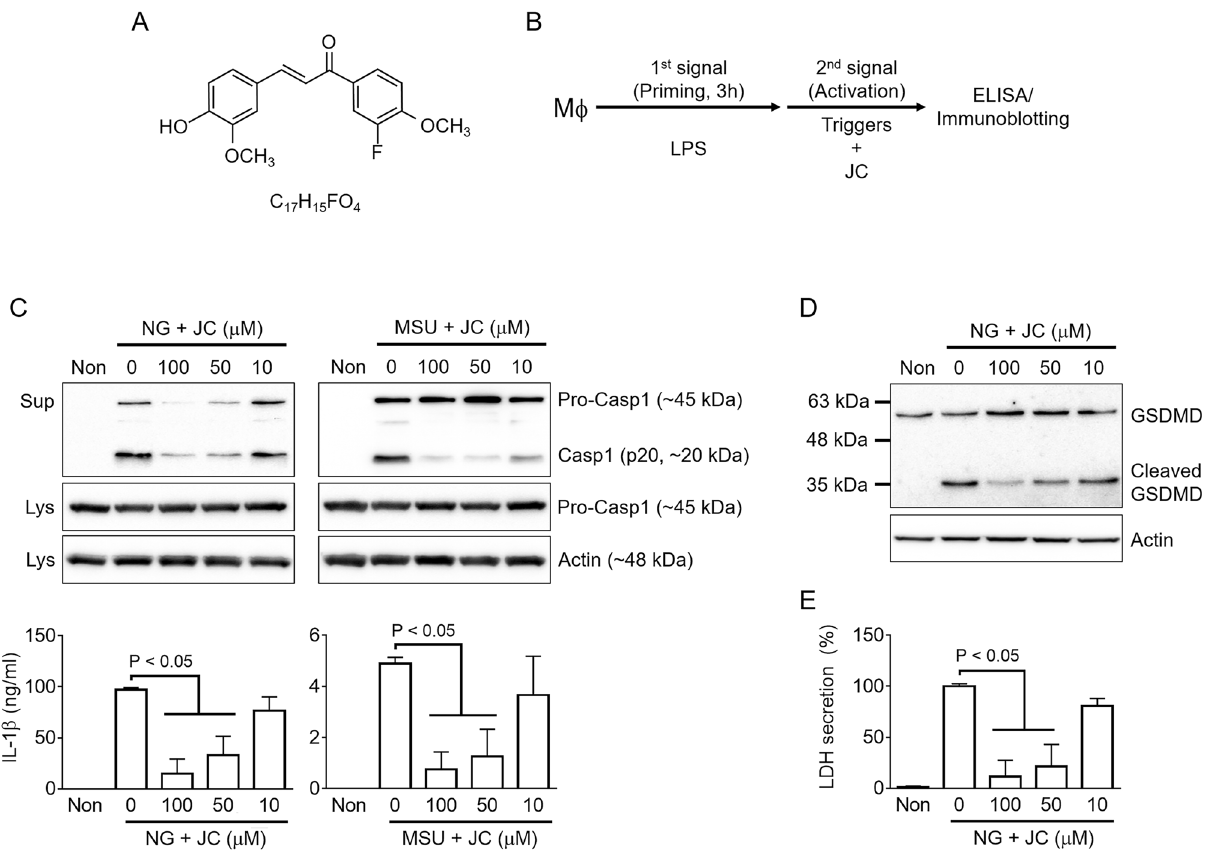
Figure 1. Effects of JC on NLRP3 inflammasome activation. ( A ) Chemical structure of JC2-11 (JC), a chalcone derivative. ( B ) Schematic diagram of the experimental mode of inflammasome activation. Macrophages (i.e., BMDM and PMA-treated THP-1) were treated with LPS for the priming step, and the inflammasome triggers were then treated with JC as the indicated concentration. The inflammasome indices were analyzed by ELISA and immunoblotting. C , LPS-primed BMDMs were treated with the NLRP3 inflammasome triggers (i.e., NG and MSU) with JC, as indicated. The cleavage of caspase-1 (Casp1) was observed by immunoblotting, and the secretion of IL-1β was measured by ELISA. LPS-primed BMDMs were treated with NG and JC. GSDMD cleavage in the lysate ( D ) and LDH secretion ( E ) were analyzed by immunoblotting and a biochemical assay. The bar graph presents the mean ± SD with at least three independent